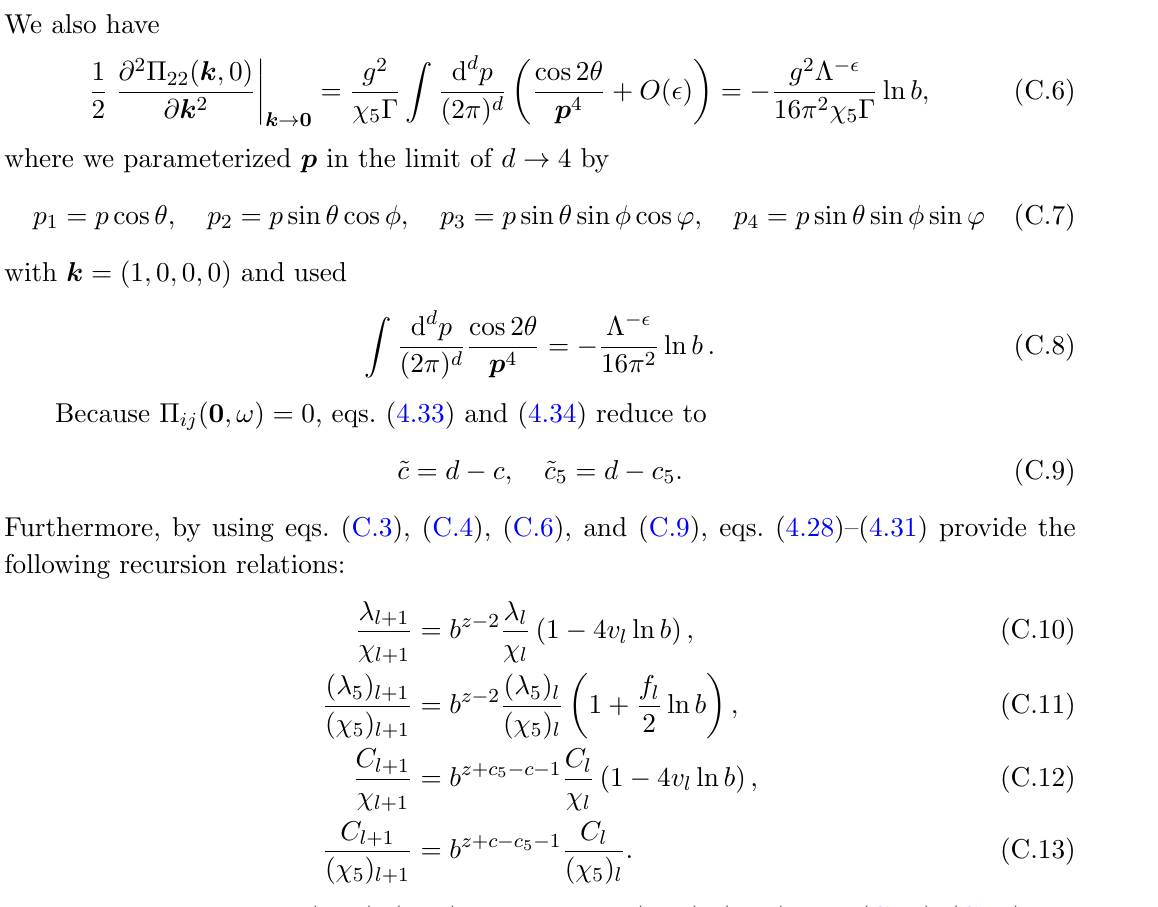
(cid:11)(cid:12) at one-loop